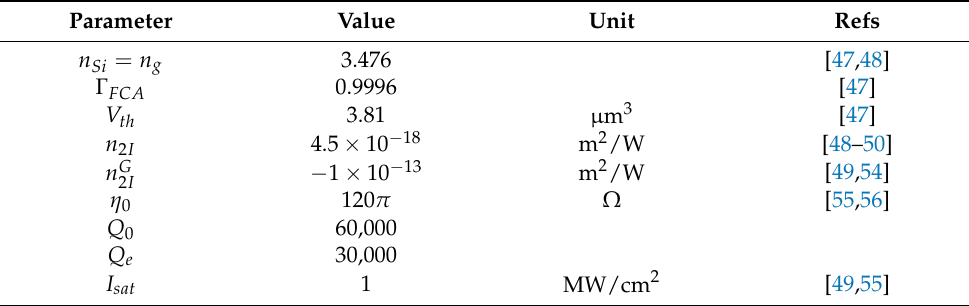
Table 1. Basic Parameters Used in MRR neuron model. Parameter